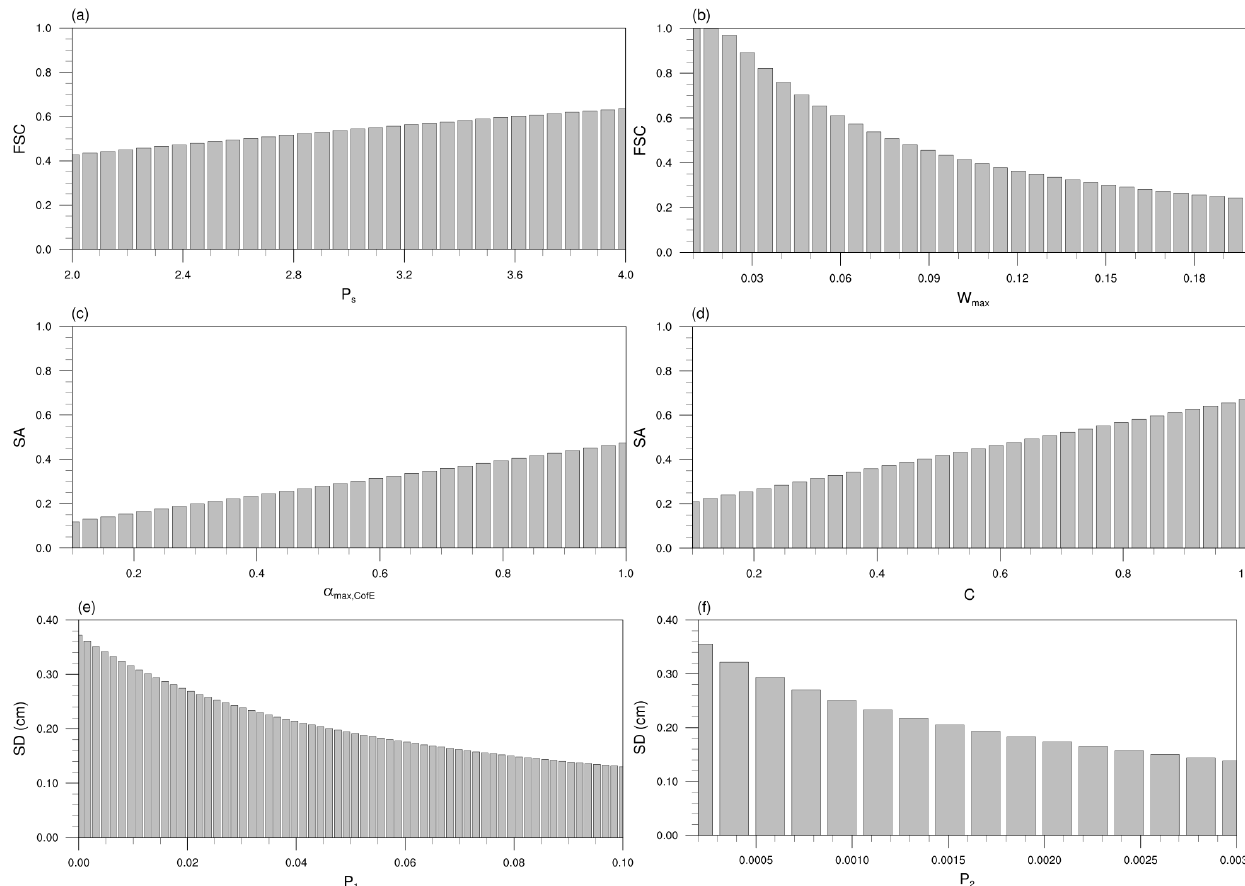
Figure 1. Responses of the snow variables to the variations in the snow-related parameters for given ranges. (a, b) Responses of FSC, for W s = 0 . 02m, to variations in P s (with W max = 0 . 08m) and in W max (with P s = 2 . 6), respectively. (c, d) Responses of SA, for α max , sat = 0 . 2 and t = 10d, to variations in α max , CofE (with C = 0 . 5) and in C (with α max , CofE = 0 . 85), respectively. (e, f) Responses of SD (cm), for W s = 0 . 02m and T air = − 5 ◦ C, to variations in P 1 (with P 2 = 0 . 0017gcm − 3 ◦ C − 1 ) and in P 2 (with P 1 = 0 . 05gcm − 3